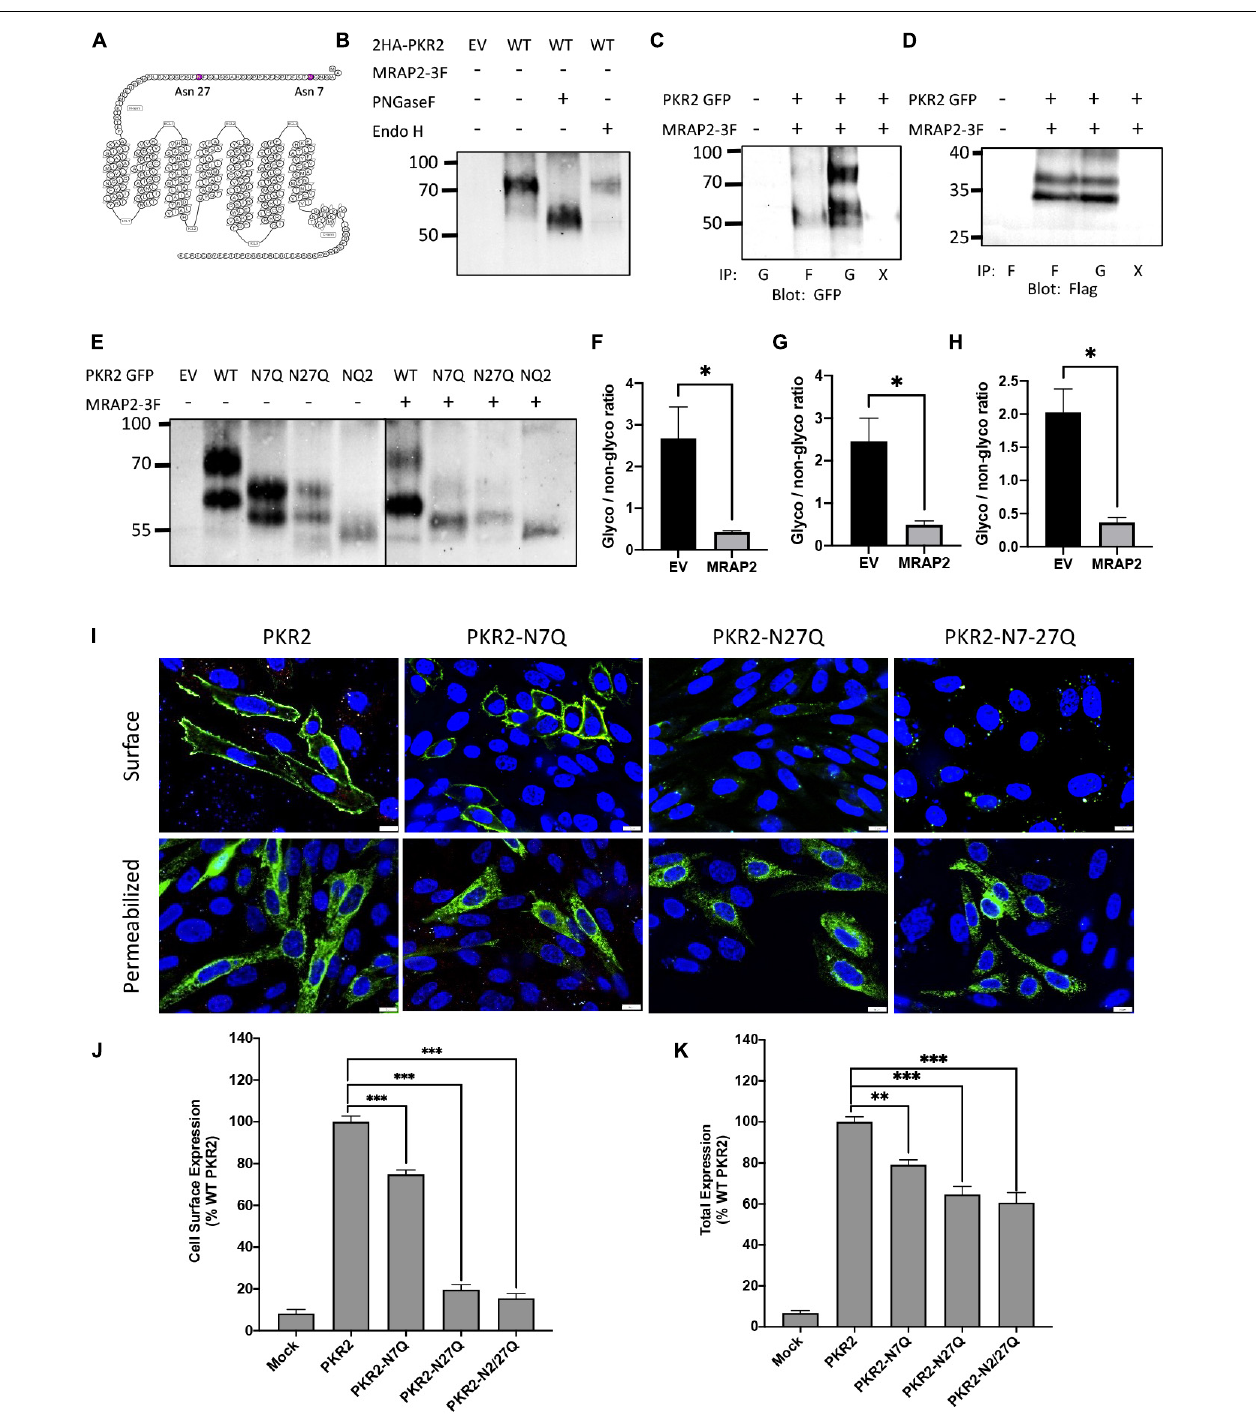
FIGURE 1 | Role of N-linked glycosylation in PKR2 trafficking. (A) Schematic depiction of human PKR2 glycosylation sites. (B) Western blot detection of untreated PKR2-GFP or PKR2-GFP treated with PNGase F or EndoH. (C,D) Western blot detection of PKR2 (C) or MRAP2 (D) following co-immunoprecipitation of PKR2-GFP and MRAP2-3XFLAG from transfected CHO cells. Immunoprecipitation was performed using beads coated with GFP nanobodies “G” or anti-Flag antibody “F.” “X” indicates that no antibody was used for the IP (beads only). (E) Western blot detection of PKR2-GFP alone or with MRAP2 treated or not with PNGase F or Endo H. (F–H) Densitometry analysis measuring the ration of glycosylated to non-glycosylated PKR2 in the presence and absence of MRAP2 for WT (F) , N7Q mutant (G) , and N27Q mutant (H) . (I) Immunofluorescence detection of 2HA-PKR2, 2HA-PKR2-N7Q, 2HA-PKR2-N27Q, and 2HA-PKR2-N7/27 in non-permeabilized and permeabilized cells. (J,K) Cell ELISA detection of 2HA-tagged PKR2 and PKR2 mutants in non-permeabilized (J) and permeabilized (K) cells. Errors are mean ± SEM. ∗ p < 0.05, ∗∗ p < 0.01, ∗∗∗ p < 0.001.